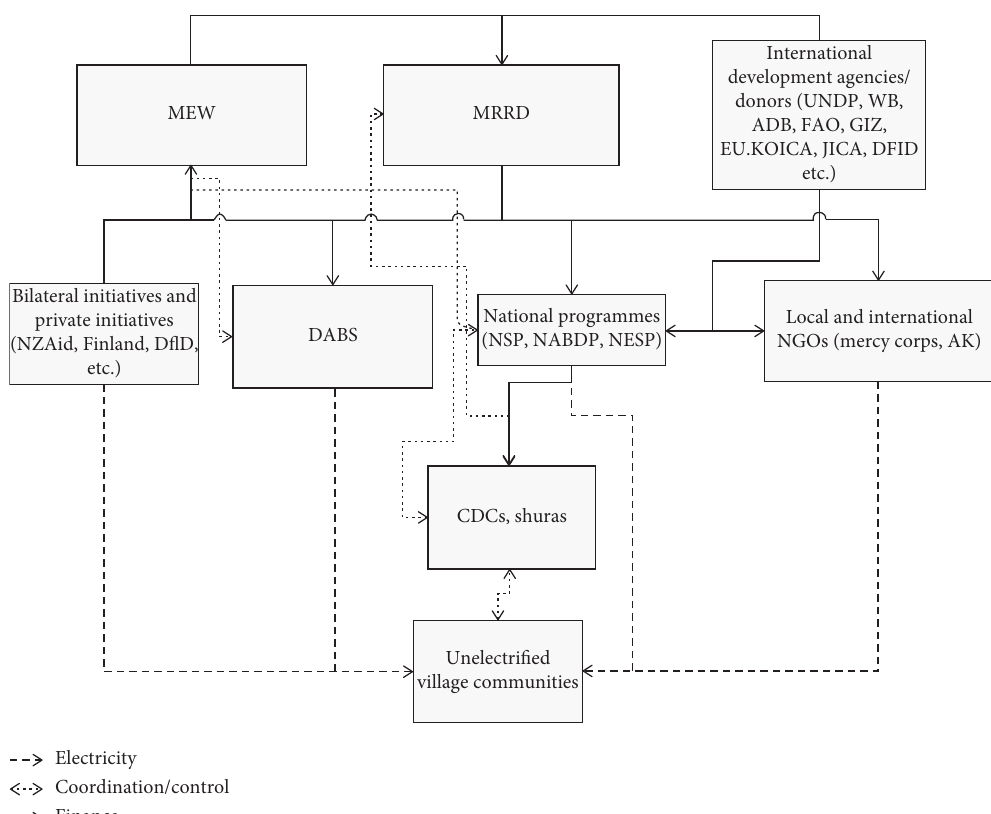
Figure 1: Institutional arrangement of rural energy sector (courtesy of UNDP 2014 (Afghanistan Sustainable Energy for Rural Development (ASERD) Project Document, UNDP, July